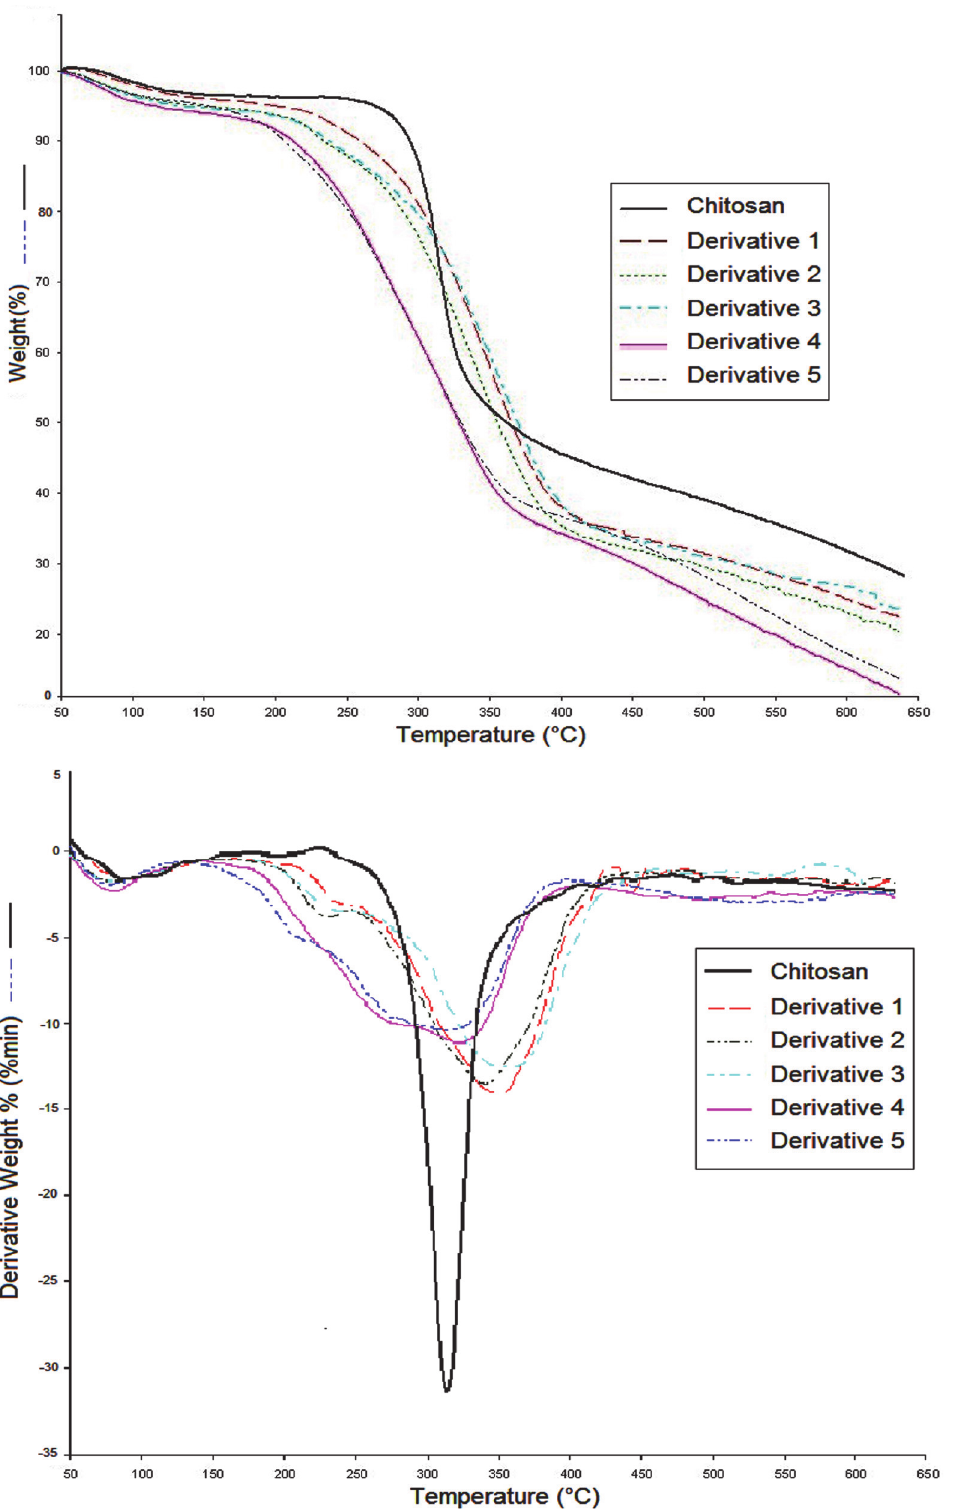
Fig 4. TGA of chitosan and derivaties. Figure showing the thermograms of chitosan and derivativesby using thermogravimetric analysis (TGA).